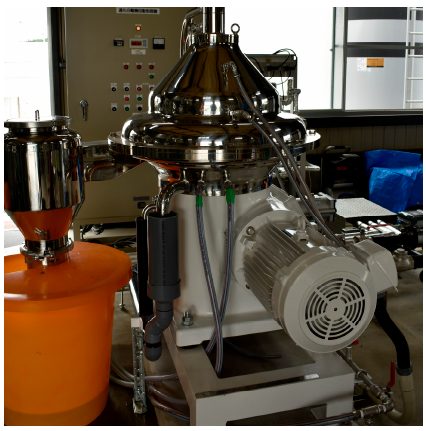
Figure 6. Centrifuge equipment at Minamisoma (15 kW, 8000 L / h). Table 6. Parameters set at flocculant sub-unit per 50 m 3 / day.